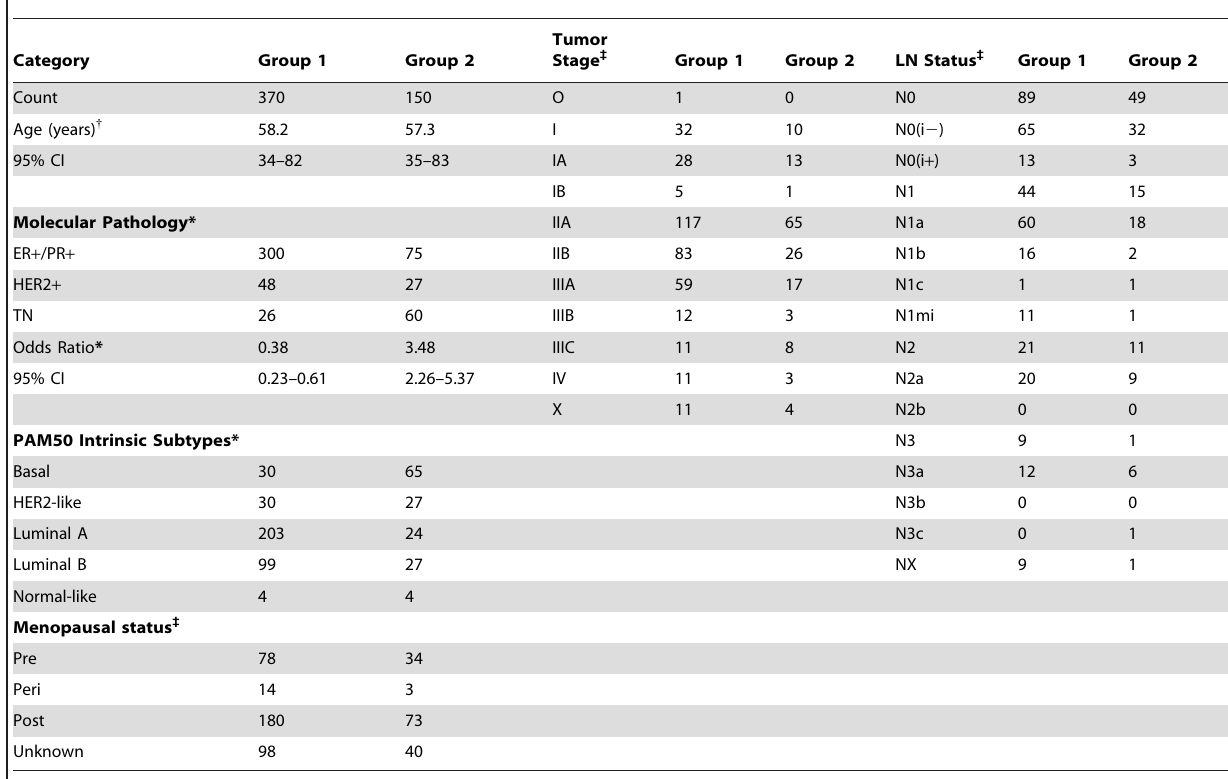
Figure 1. Expression patterns of genes associated with cell-mediated immunity clustered into two main groups. mRNA expression obtained from normal breast and invasive breast carcinoma tissue samples (columns) acquired as part of the Cancer Genome Atlas study [14] were hierarchically clustered into two groups based upon the log2 median-normalized expression ratio for genes (rows) related to cell-mediated cytotoxic immunity and tumor immunosuppression, as listed in Table 1. Tissue samples were characterized by morphology (i.e., normal, ductal, lobular, or other) and molecular histology (i.e., expression of the estrogen receptor (ER + ), progesterone receptor (PR + ), or HER2 (HER2 + )), as highlighted by the blue bars on top. Gene expression is shown as a row-normalized heatmap. Red denotes under-expressed and violet denotes over-expressed relative to the population mean. Dendrogram indicates the degree of similarity among genes (rows) or samples (columns) using the Ward’s minimum distance method in R.